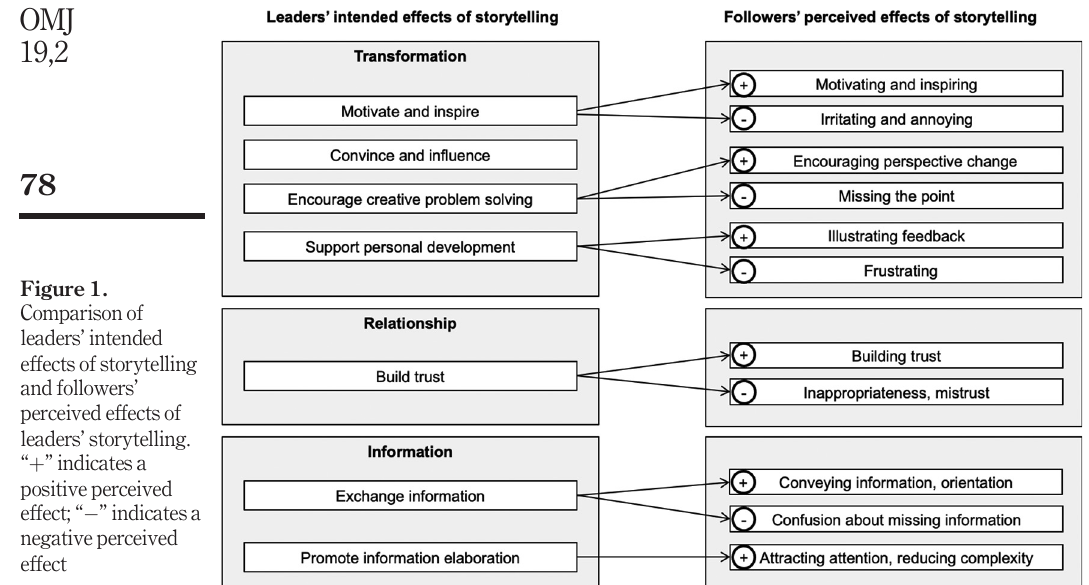
Figure 1. Comparison of leaders ’ intended effects of storytelling and followers ’ perceived effects of leaders ’ storytelling. “ þ ” indicates a positive perceived effect; “ (cid:2) ” indicates a negative perceived